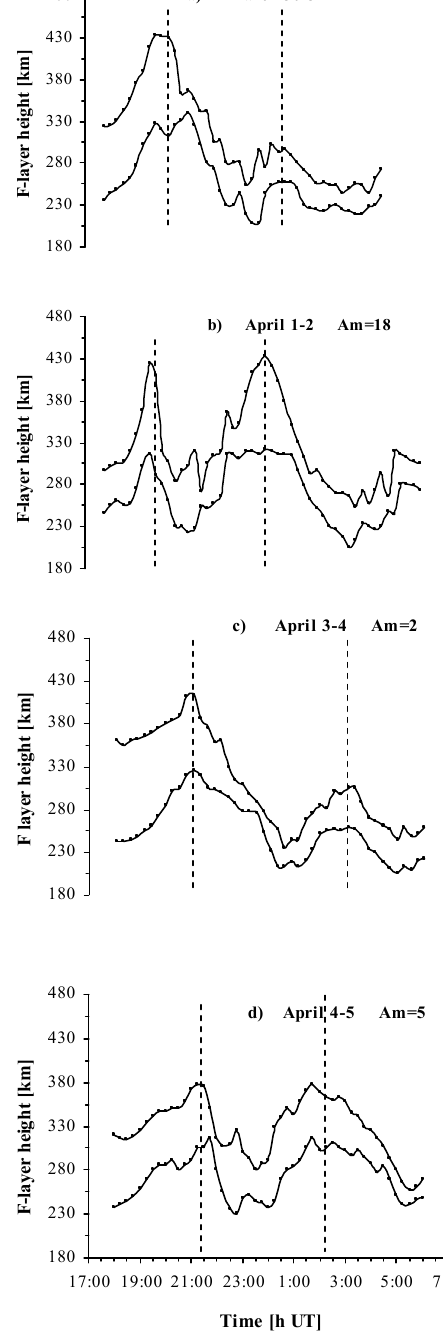
Fig. 4. Night to night variability of the bottom height h 0 F and the height of the maximum electronic density hpF of the F2 layer in kilometres (y-axis) as a function of UT time (x-axis) for four nights with B-type contours, (a) 30–31 March, (b) 1–2 April, (c) 3–4 April, (d) 4–5 April. The dashed lines indicate the successive positions of the peaks from one night to the